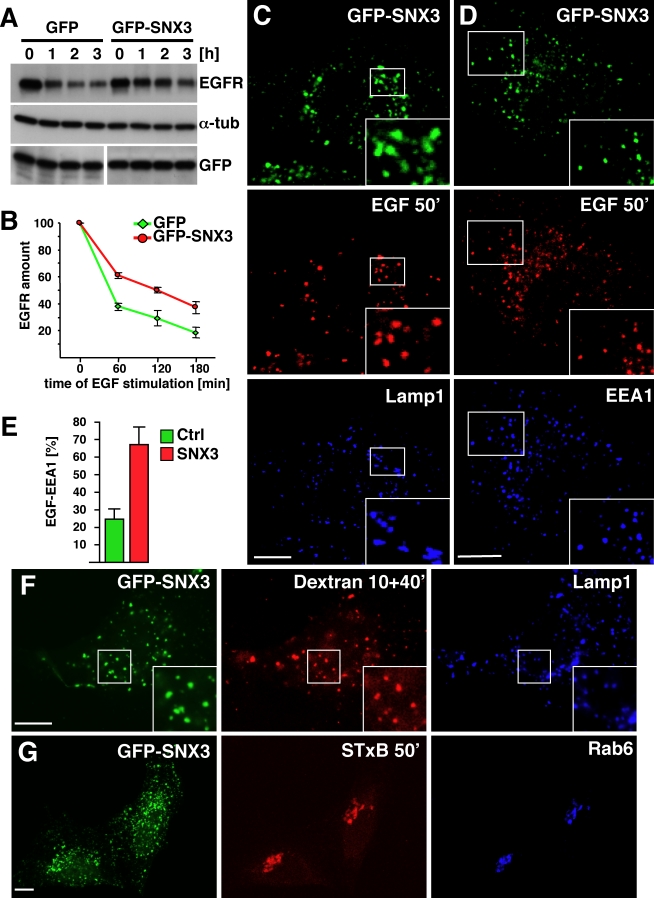
SNX3 in Endosomal Transport(A and B) HeLa cells expressing GFP-SNX3 were incubated with 0.25 μg/ml EGF and 10 μg/ml cycloheximide for the indicated time periods. Cell lysates (100 μg) were analyzed by SDS gel electrophoresis and western blotting with antibodies against EGFR (20-ESO4 against a peptide of the cytoplasmic domain), α-tubulin (α-tub), or GFP. Blots were scanned and the quantification is shown in (B).(C and D) After cell surface binding, biotin-EGF coupled to streptavidin-R-phycoerythrin was internalized for 50 min at 37 °C in HeLa cells expressing GFP-SNX3. Cells were labeled with antibodies against Lamp1 (C) or EEA1 (D) and analyzed by triple channel fluorescence. The various combinations of merged colors for (C) and (D) are shown in Figure S3A and S3B, respectively. Insets in the lower right are a magnification of the regions shown in the boxes.(E) Individual endosomes containing both EGF and EEA1 were counted in (D) and in control cells (Figure S4A). Values are expressed as a percentage of the total number of EGF-containing endosomes (>10 cells per experiment).(F) Rhodamine-dextran was pulsed for 10 min at 37 °C in HeLa cells expressing GFP-SNX3 and then chased for 40 min. Cells were analyzed as in (C and D) using antibodies against Lamp1, and the various combinations of merged colors are in Figure S3C.(G) After cell surface binding, Shiga toxin B-subunit conjugated to Cy3 was internalized for 50 min at 37 °C into HeLa cells expressing GFP-SNX3. Cells were analyzed as in (C and D) using antibodies against Rab6, and the various combinations of merged colors are the same as in Figure S3D.In (B and E), each condition is the mean of three independent experiments; standard errors are indicated.(C, D, F, and G) Scale bar indicates 10 μm.